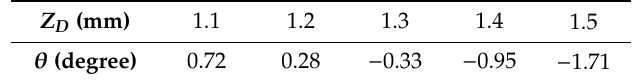
Table 2. Skirt spring-back of the circular cup shape based on Z D in the step 4.